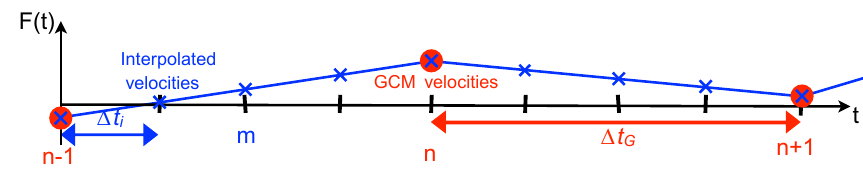
Figure 1. Schematic illustration of how the transport fields F(t) are updated and interpolated in time between the stored GCM data, which are read in at the time t n and are separated in time by the time interval (cid:49)t G (in red). The fields are then linearly interpolated at the points in blue with intermediate time steps. The number of intermediate time steps between two GCM velocities is in this example I S = (cid:49)t G /(cid:49)t i =